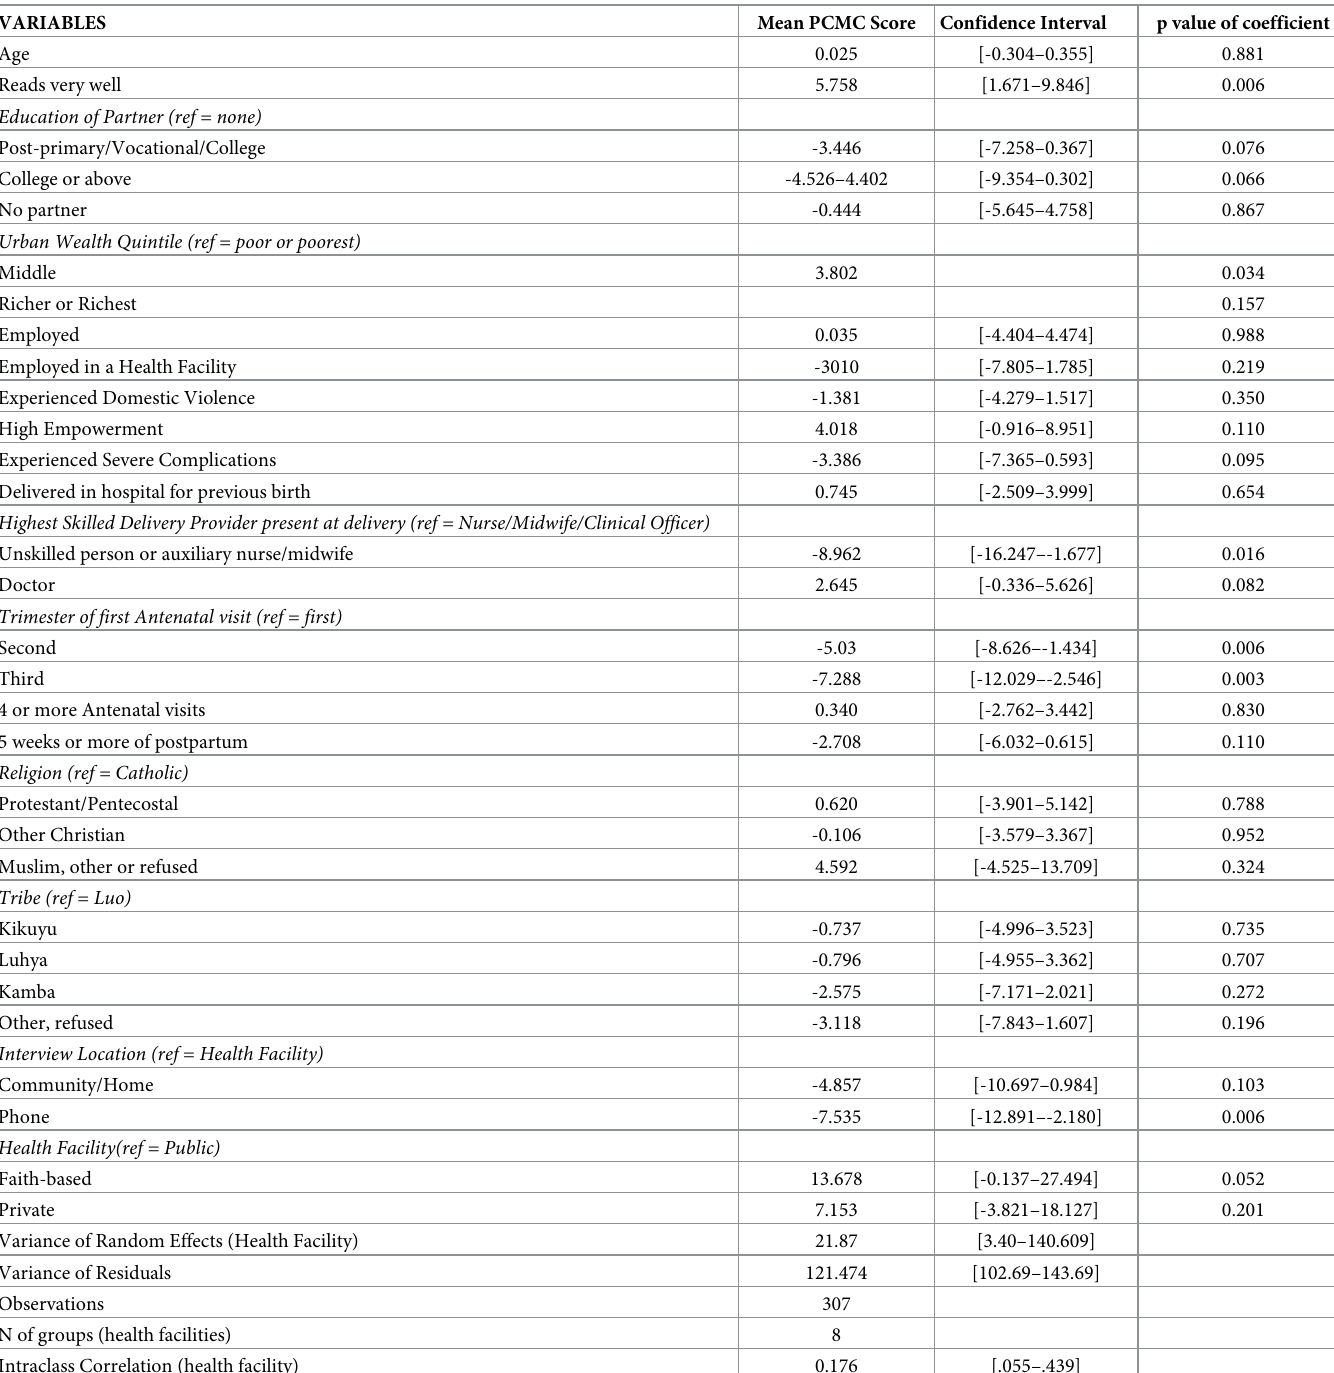
Table 4. Multilevel model examining associations between PCMC score and selected